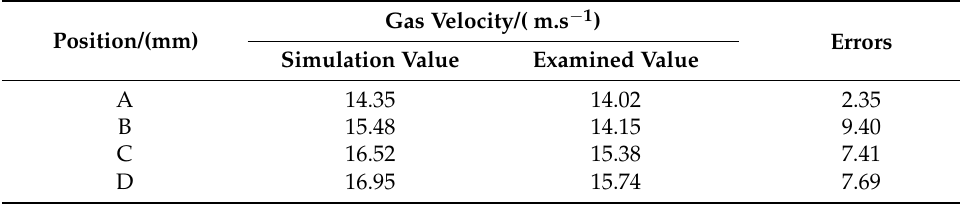
Table 4. Comparison of simulated value and examined value of outlet velocity.